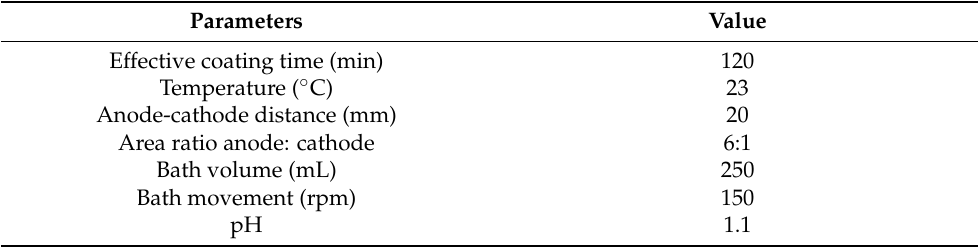
Table 2. Coating parameters.